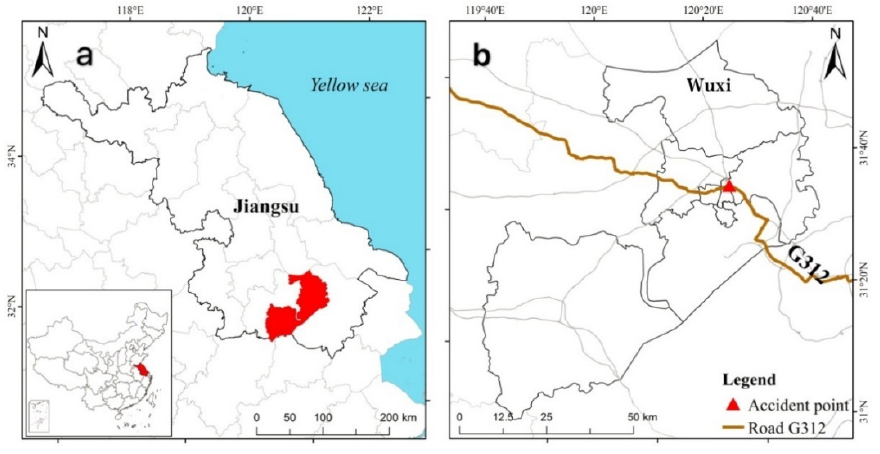
Figure 2. Location of Wuxi ( a ), G312 and accident site ( b ).